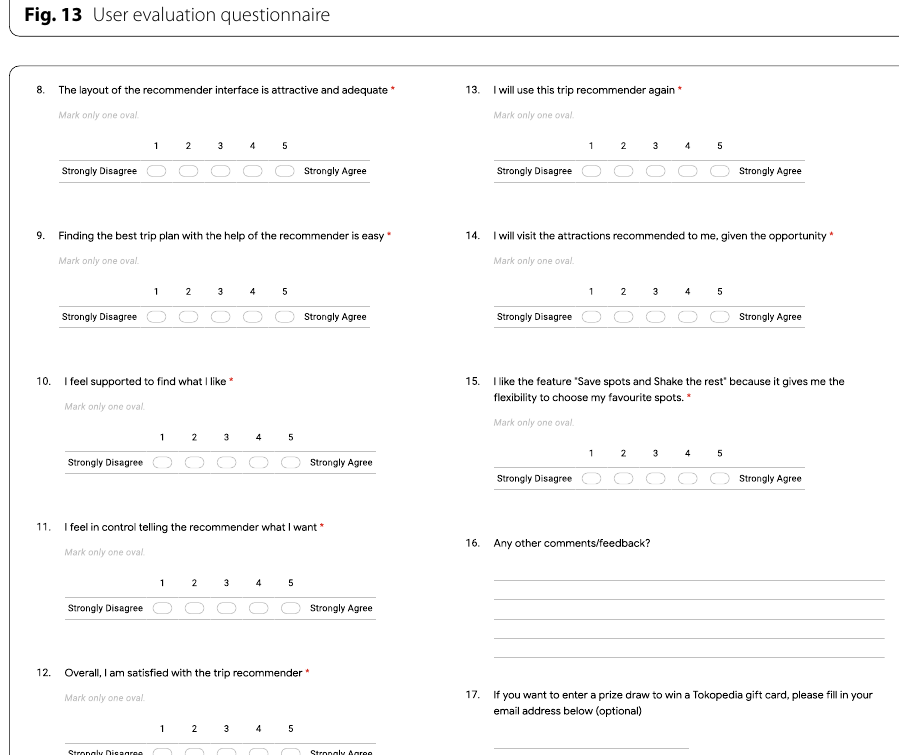
Fig. 13 User evaluation questionnaire